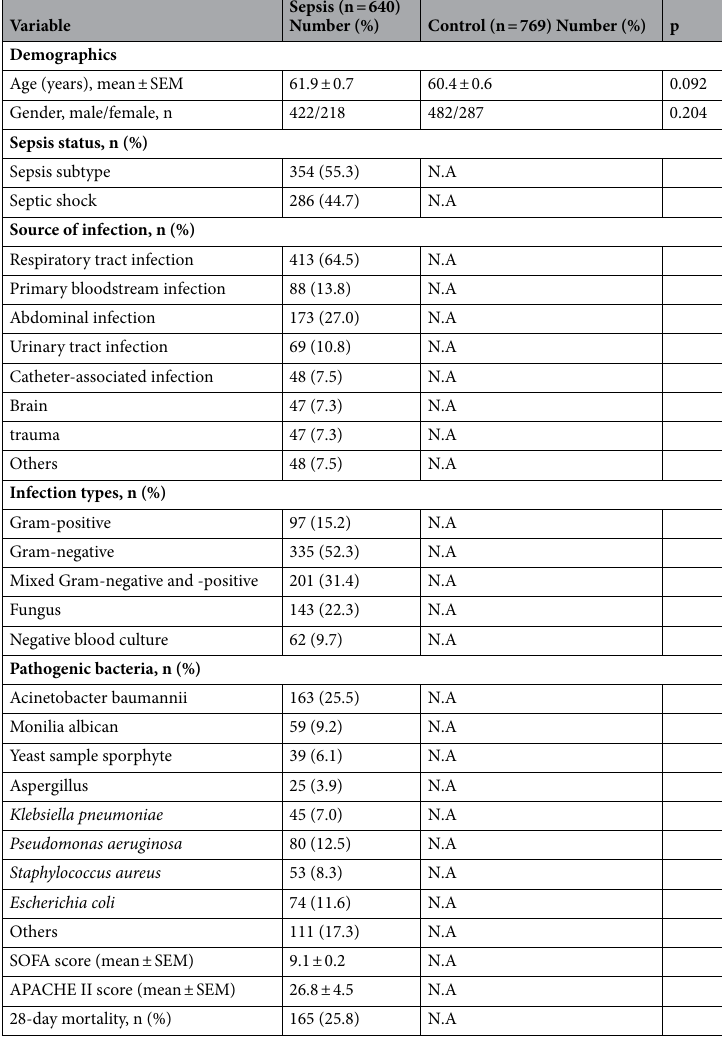
Table 1. Clinical characteristics of sepsis patients and healthy controls. N.A not applicable, SOFA Sequential Organ Failure Assessment, APACHE II Acute Physiology and Chronic Health Evaluation